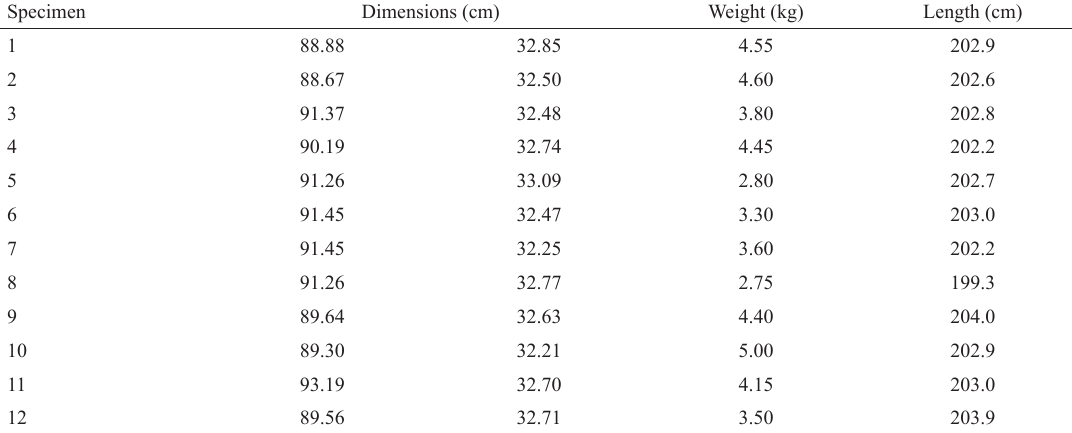
Table 2: Dimensions of specimens with finger joint. Specimen